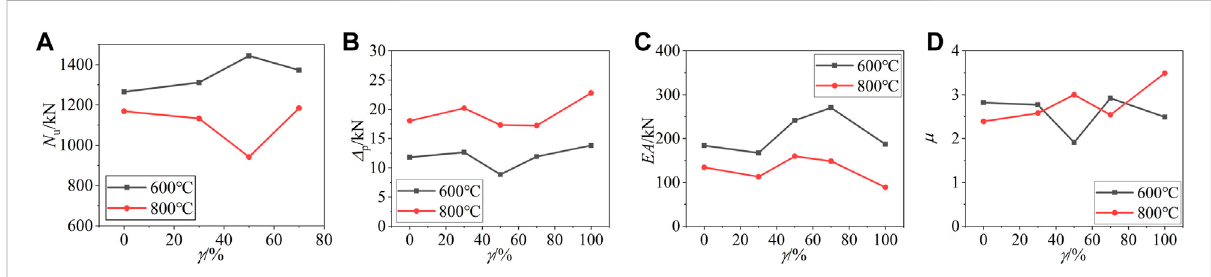
FIGURE 9 In fl uence of replacement ratio on mechanical properties. (A) peak load; (B) peak displacement (C) initial stiffness (D) displacement ductility coef fi